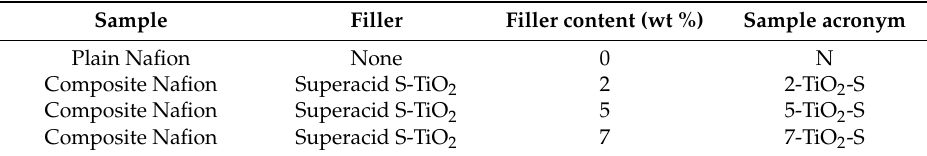
Table 1. Plain Nafion and composite Nafion membranes investigated in this